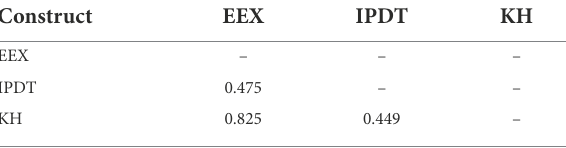
TABLE 3 Discriminant validity (HTMT; mediation).